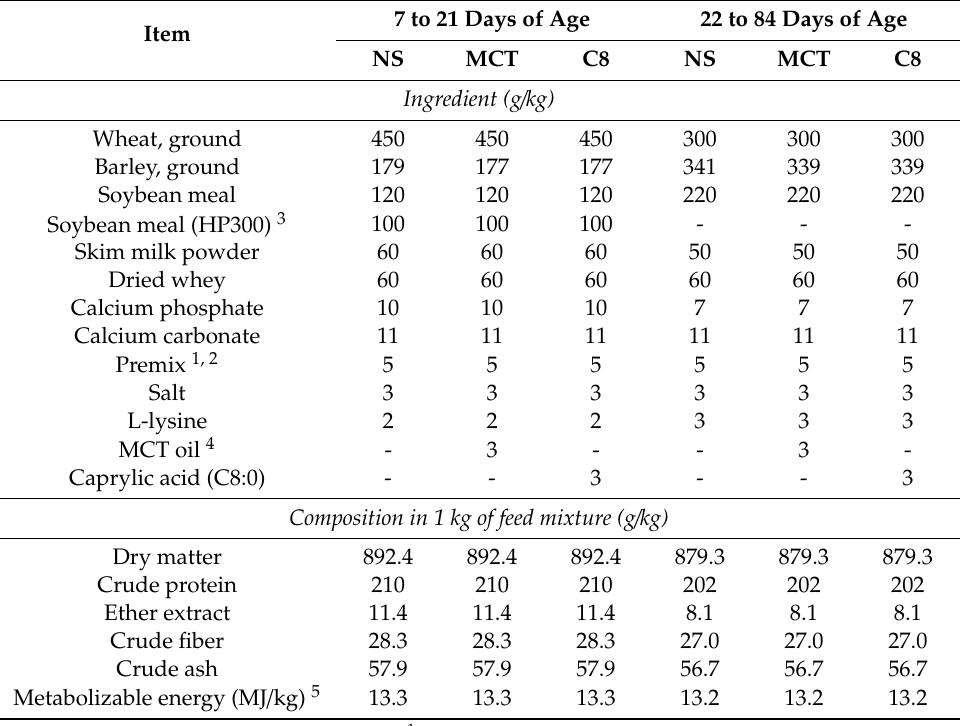
Table 2. Components and chemical composition of piglet